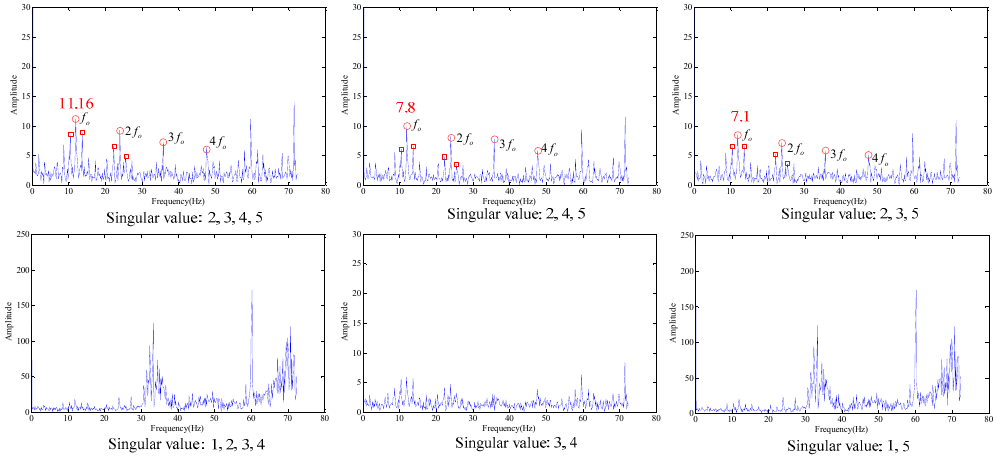
Figure 24. Filtering effective under different singular value.